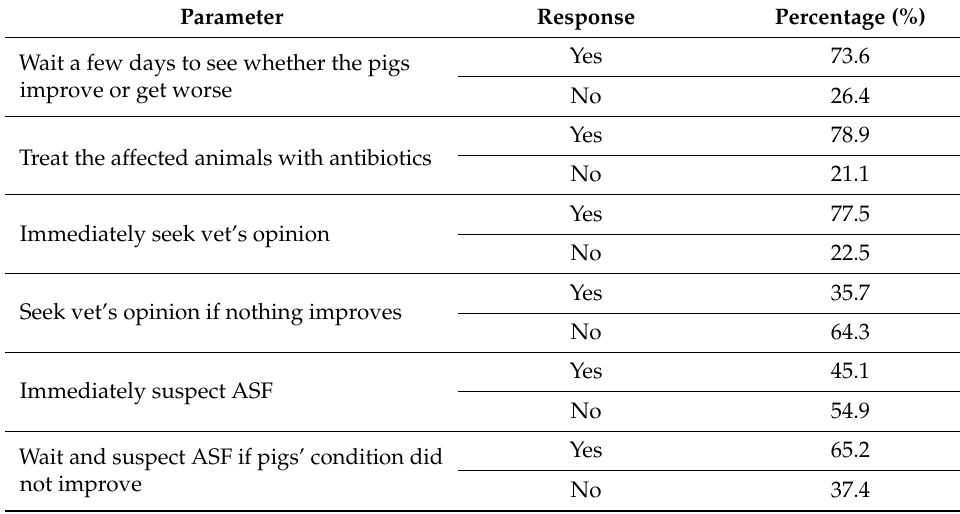
Table 6. Farmers reaction toward fever, redness on skin, reduced eating and no increase in mortality. Parameter